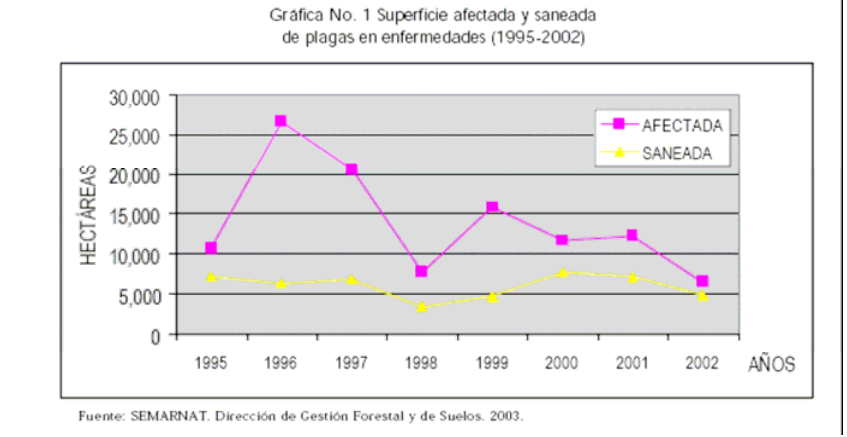
FIGURE 6 . History of forest pest activity in